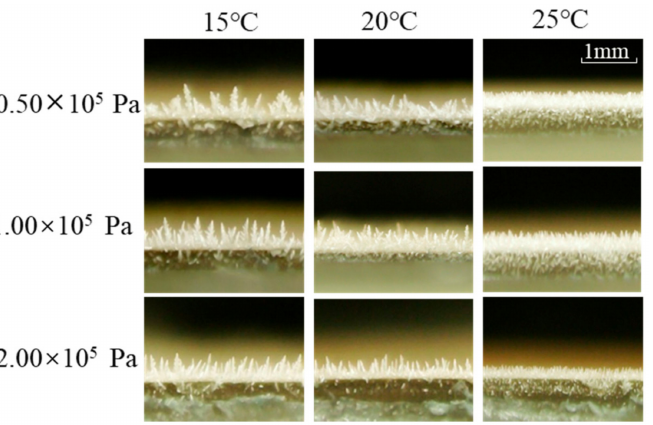
Figure 10. Frost crystal morphologies with working pressure around cooling surface under different temperatures of humid air at 10